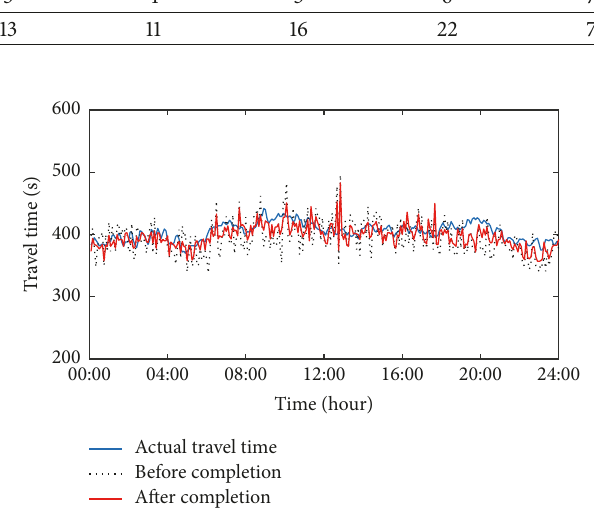
Figure 14: Travel time prediction result curves